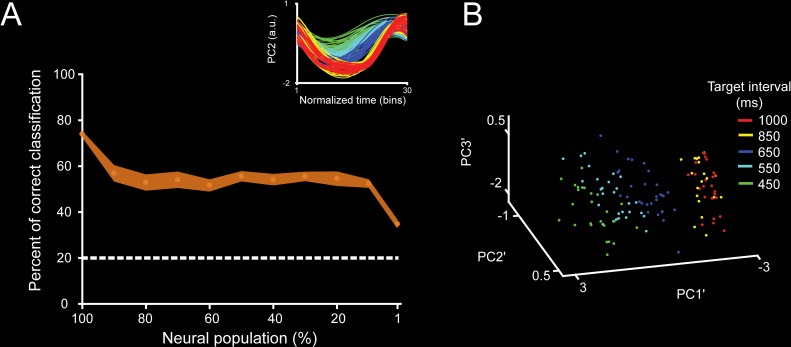
Trajectory classifier robustness across neural population sizes during SCT.A. SVM classifier performance (mean ± SD of percent of correct classifications) for target interval (five instructed intervals) during the SCT task based on the neural trajectory computed from different population sizes. The total initial population size was of 1,477 neurons. Dotted lines correspond to random level. The neurons with the largest PC participation were removed in steps of 10% of the original population size, until reaching 1% of the original population. Inset shows the original time-normalized neural trajectory PC used to generate the second-layer PCA′. B. Point cloud in 3D for the second-layer PCAs’ for target interval. See color code in the inset. Note that the percentage of correct classification decreased as a function of the population size; however, the classification was above chance even for the trajectories based on small cell ensembles. Underlying data are available in https://doid.gin.g-node.org/d315b3db0cee15869b3d9ed164f88cfa/. a.u., arbitrary unit; PC, principal components; PCA, principal component analysis; SCT, synchronization-continuation task; SVM, support vector machine.